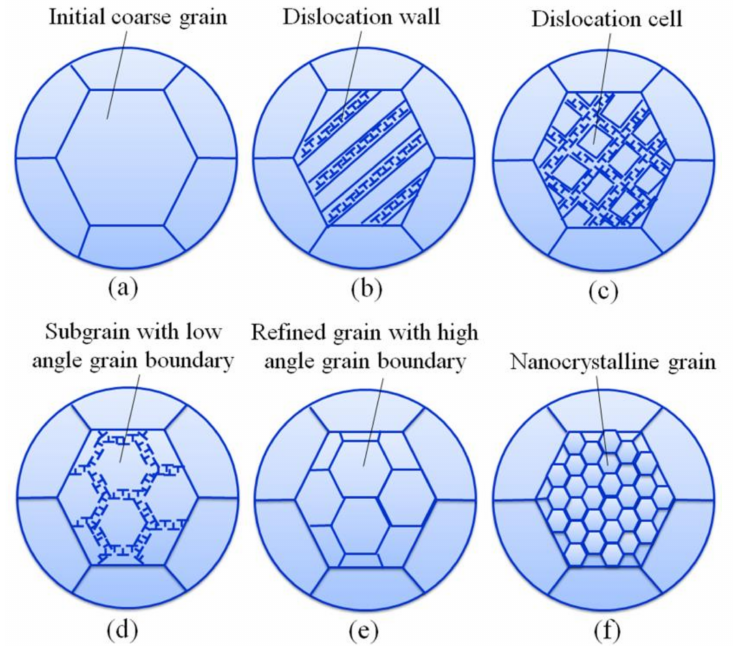
Figure 11. Schematic diagram of the plastic deformation mechanism for the nanocrystallization of nickel-based alloy: ( a ) Initial coarse grain; ( b ) Dislocation walls formed as a result of dislocation slip; ( c ) Dislocation cells formed as a result of dislocation slip; ( d ) Subgrains with low angle grain boundary induced due to dislocation slip; ( e ) Grain refinement along with the occurrence of high angle grain boundary; ( f ) Nanocrystalline grain formed due to severe plastic